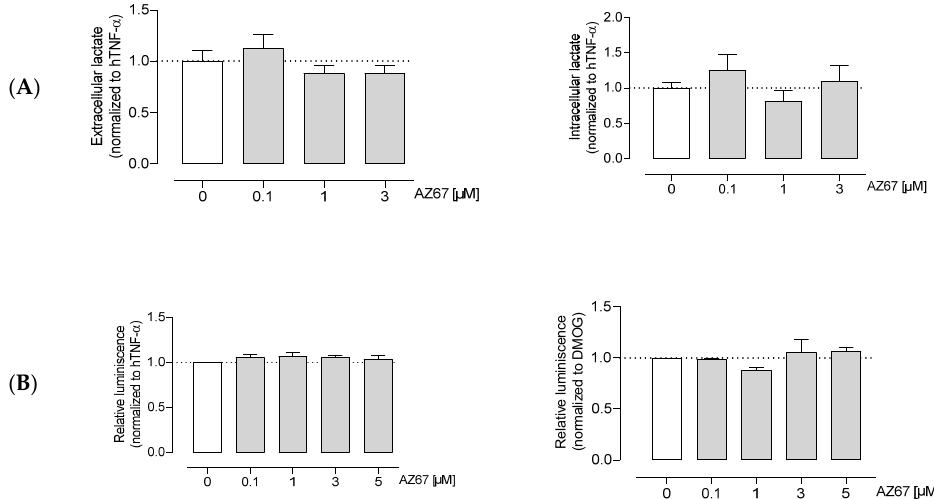
Figure 3. AZ67 does not inhibit glycolysis in ECs. ( A ) HAOEC were cultured and treated with AZ67 (0.1, 1, 3 µ M) supplemented with 20 ng/mL hTNF- α for 16 h. Extracellular and intracellular L-lactate was measured to evaluate glycolysis. Data represented as mean ± SEM; N = 6, p > 0.05 (one-way ANOVA). ( B ) Total cellular ATP was measured using the CellTiter-Glo assay. Cells were stimulated with 20 ng/mL hTNF- α ( left ), or 1 mM DMOG ( right ) for 24 h, followed by treatment with AZ67 (0.1, 1, 3, 5 µ M) with the concomitant addition of hTNF- α or DMOG for an additional 24 h. Data represented as mean ± SEM; N = 4–5, p > 0.05 (one-way ANOVA).